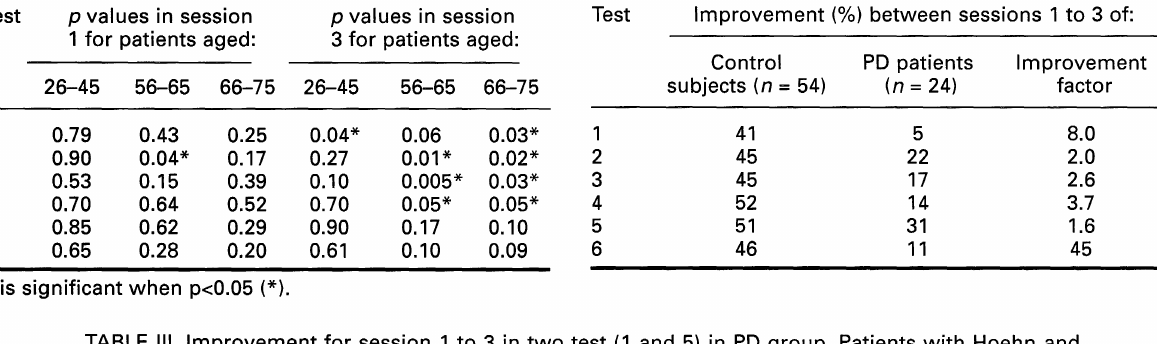
TABLE III. Improvement for session 1 to 3 in two test (1 and 5) in PO group. Patients with Hoehn and Yahr scale for 1 to 3, patients with tremor or not, patients without treatment and patients with at least levodopa.